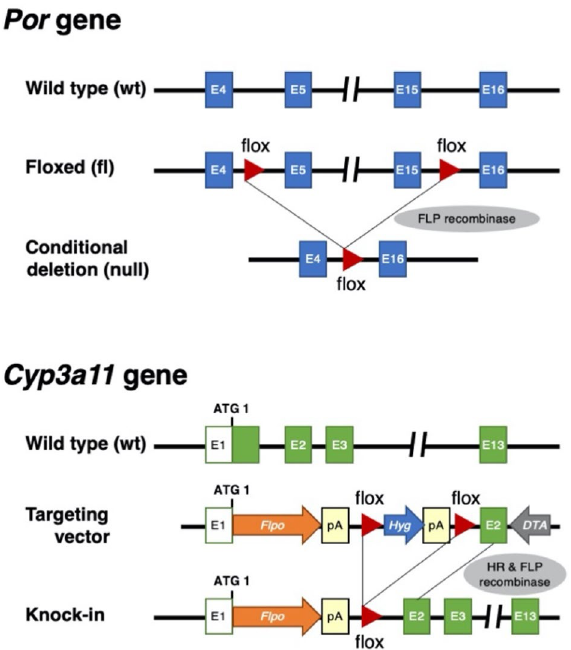
Figure 1. Schematic representation of deleted loci of Por gene and Flpo recombinase knocked-in loci of Cyp3a11 in the POR conditional knockout mice. pA poly A signal, HR homologous